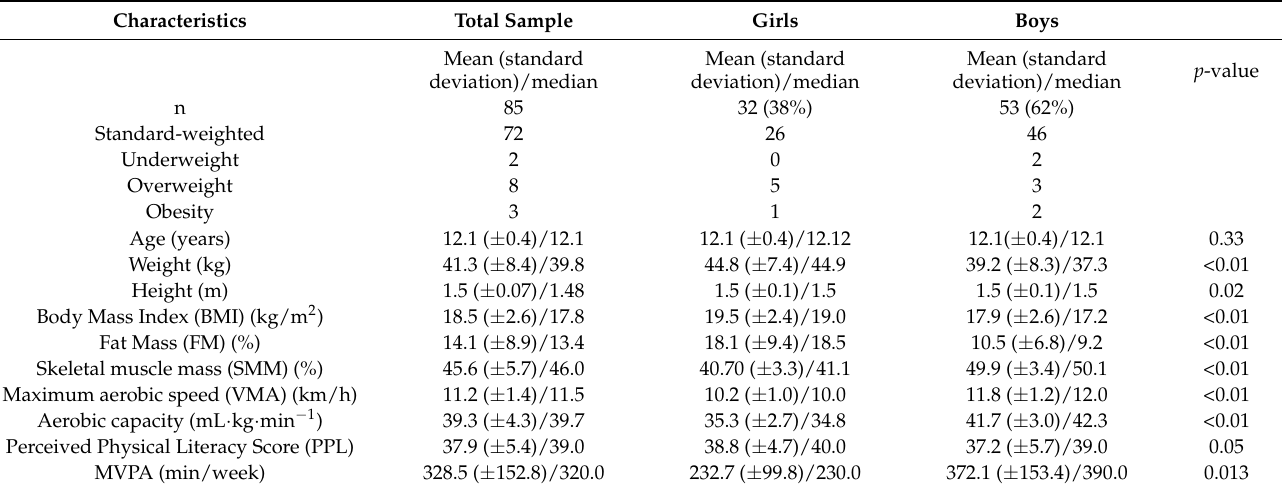
Table 1. Characteristics of participants (n =